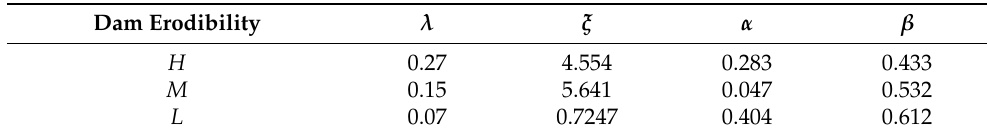
Table 1. Calculation parameters of peak discharge of landslide dam with different erodibility. “ H ” refers to the high erodibility of the landslide dam, “ M ” refers to the moderate erodibility of the landslide dam, “ L ” refers to the low erodibility of the landslide dam. Dam Erodibility λ ξ α β H 0.27 4.554 0.283 0.433 M 0.15 5.641 0.047 0.532 L 0.07 0.7247 0.404